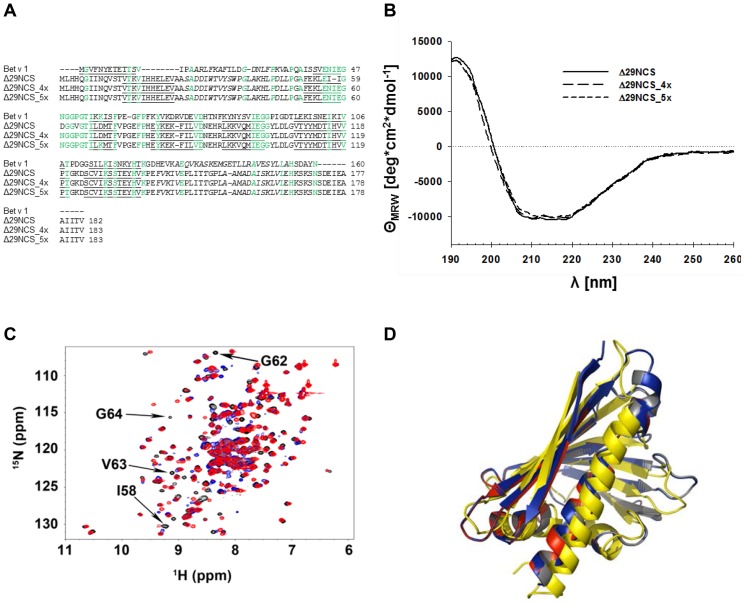
Δ29NCS, Δ29NCS_4x, and Δ29NCS_5x structures are virtually identical to the Bet v 1 structure.(A) Structural sequence alignment. β-strands (underlined), helices (italic), and amino acid identities (green) to Bet v 1 (pdb: 1BV1) are 23.8% (Δ29NCS), 26.8% (Δ29NCS_4x), and 27.5% (Δ29NCS_5x), respectively. (B) Circular dichroism of Δ29NCS variants. (C) Overlay of three 1H-15N-HSQC spectra of Δ29NCS variants. Black arrows, signals numbered and named according to Δ29NCS. Black: Δ29NCS, blue: Δ29NCS_4x, red: Δ29NCS_5x. The arrows highlight signals of selected amino acids that are expected to differ between the three Δ29NCS variants. Labeling is according to Δ29NCS scheme. (D) Overlay of secondary structure topologies of Δ29NCS (grey), Δ29NCS_4x (blue), Δ29NCS_5x (red), and Bet v 1 (yellow).